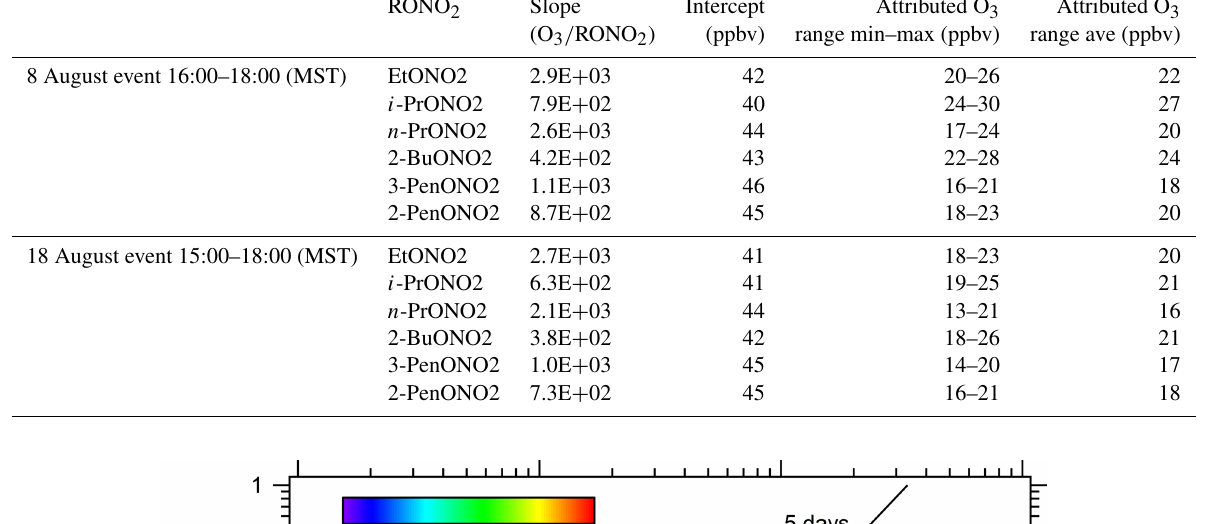
Table 3. Summary of the O 3 / RONO 2 slopes (ppbv/ppbv), intercept values (ppbv), the range of O 3 attributable to each parent alkane, and the average O 3 attributable to each parent alkane based on the correlation in each of the O 3 –alkyl-nitrate scatter plots for the upslope events on 8 and 18 August. An orthogonal distance regression was used to determine the slope and intercept. RONO 2